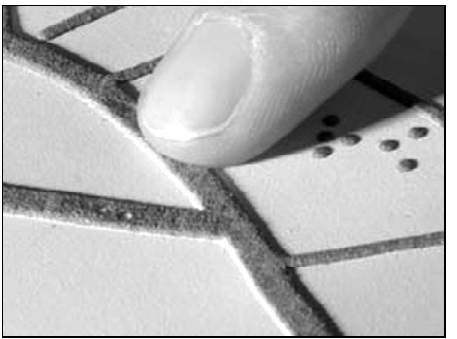
Fig 1. A fragment of a tactile map